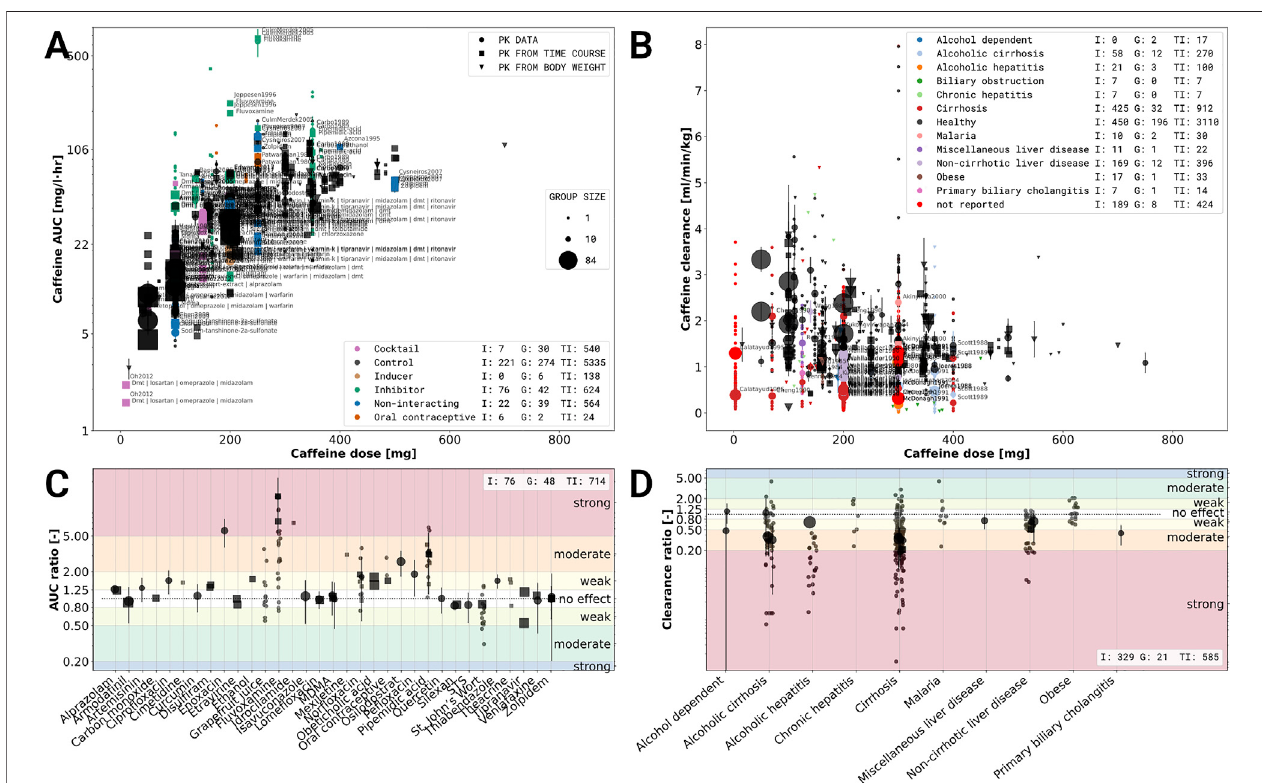
FIGURE 5 | Effects of caffeine-drug and caffeine-disease interactions. (A) Caffeine-drug interactions based on the caffeine area under the concentration curve (AUC).Dataisstrati fi edbasedonco-administrationofdrugswithcaffeineanddose.Violet:caffeineadministratedaspartofadrugcocktail.Commonco-administrations are dextrometorphan, metoprolol, midazolam, omeprazole, and warfarin.; Black: single caffeine administration (no co-administration); Brown: co-administration with an inducing effect on the elimination of caffeine; Green: co-administration with an inhibiting effect on the elimination of caffeine; Blue: co-administrations with no effect